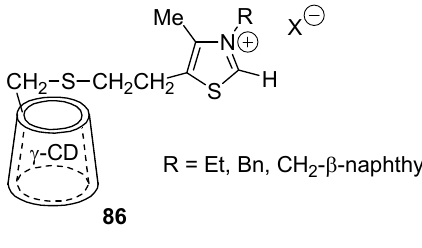
Figure 13. Structure of 86.